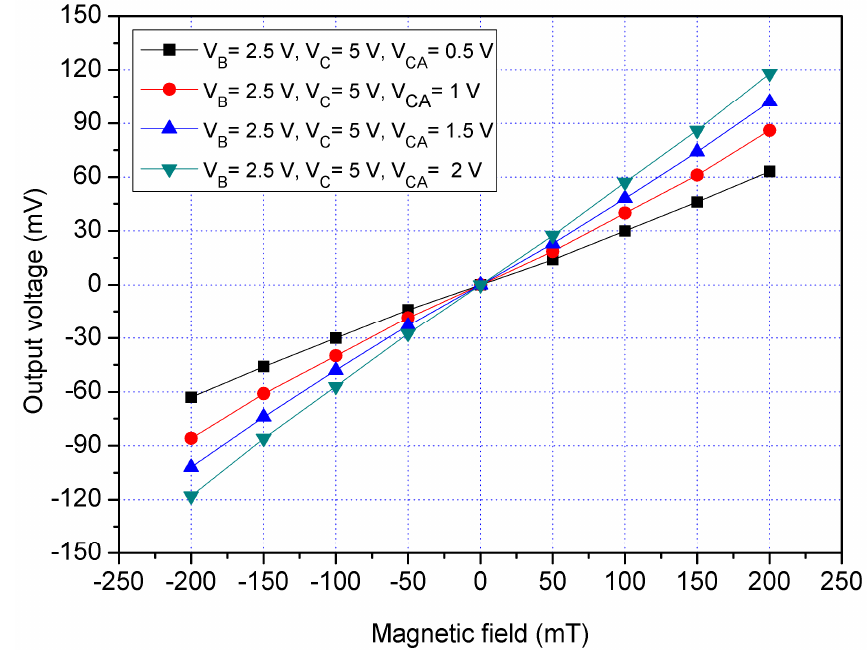
Figure 3. Simulated output voltage (Vo) in the x-direction MF.